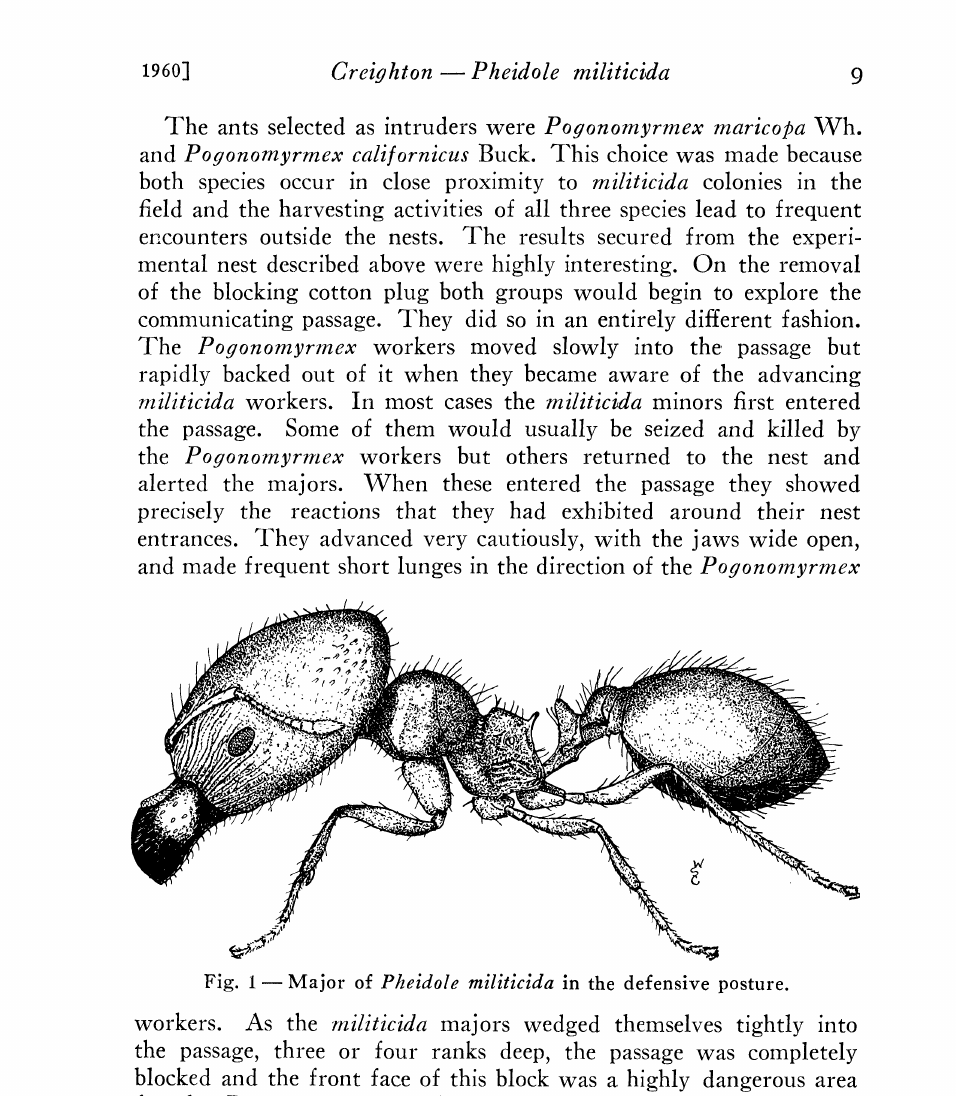
Fig. 1- Major of Pheidole militidda in the defensive